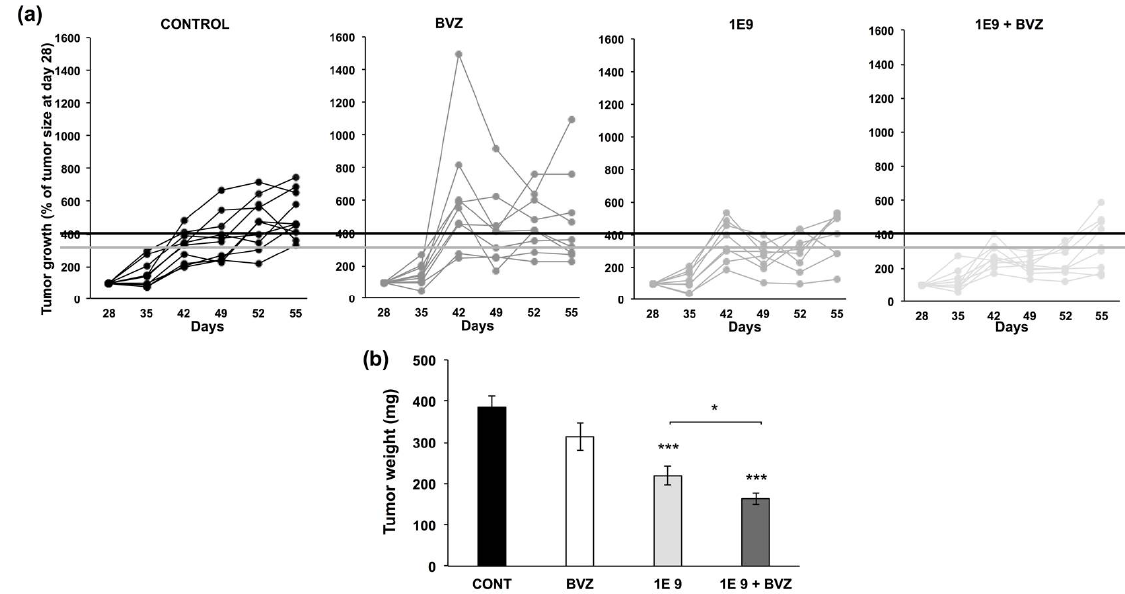
Figure 4. 1E9 antibodies inhibit the growth of experimental ccRCC and counteract the detrimental effects of bevacizumab (BVZ). ( a ) Comparison of the growth of experimental ccRCC in nude mice in the presence of control antibodies (CONTROL), BVZ, 1E9 antibodies (1E9), or a combination of IE9 antibodies and BVZ (1E9 + BVZ) administered twice a week at 5 mg/kg. ( b ) Tumor weight at sacrifice. Statistics are indicated; *, p <0.05; *** p < 0.001.